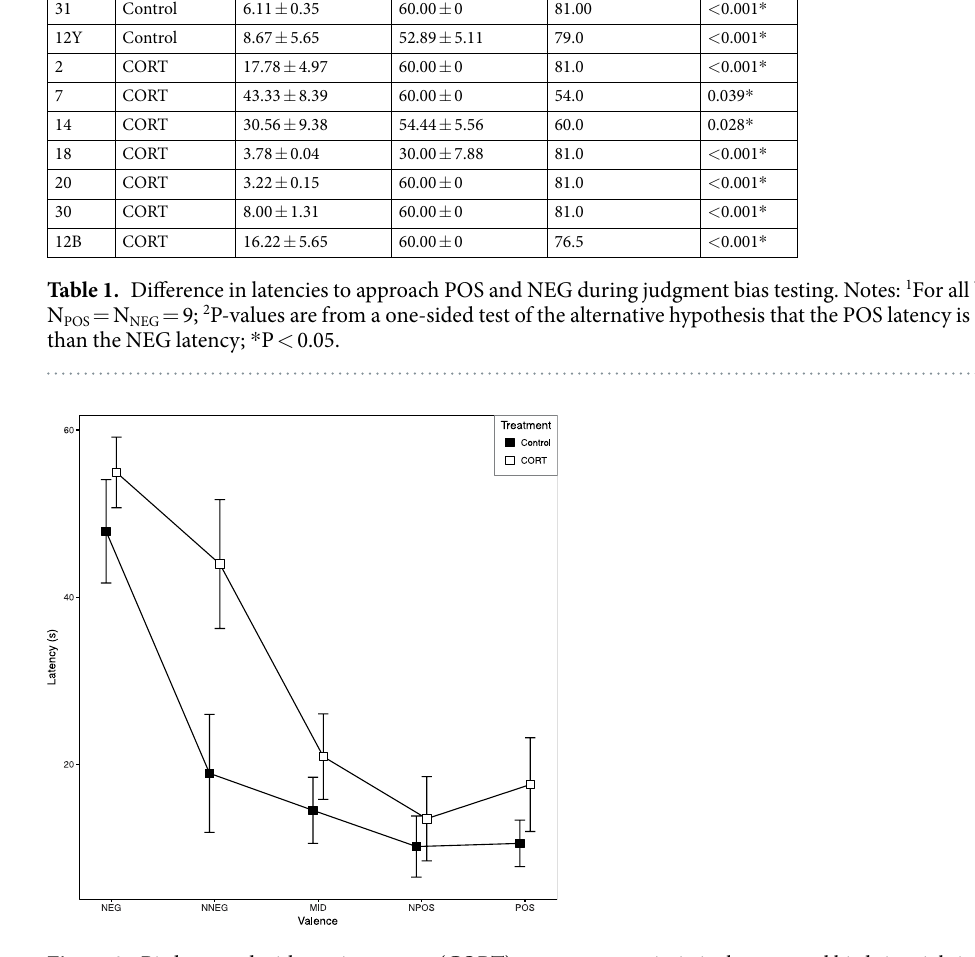
Figure 2. Birds treated with corticosterone (CORT) were more pessimistic than control birds in trials in which the cone was placed at the near-negative location (NNEG). Line graph showing the mean ± 1 SEM latencies of the birds in the two treatment groups to approach the cone at each of the five locations in the judgment bias test. The significant valence x treatment interaction (see text for details) occurs because the CORT birds were slower to approach the NNEG cone than the control